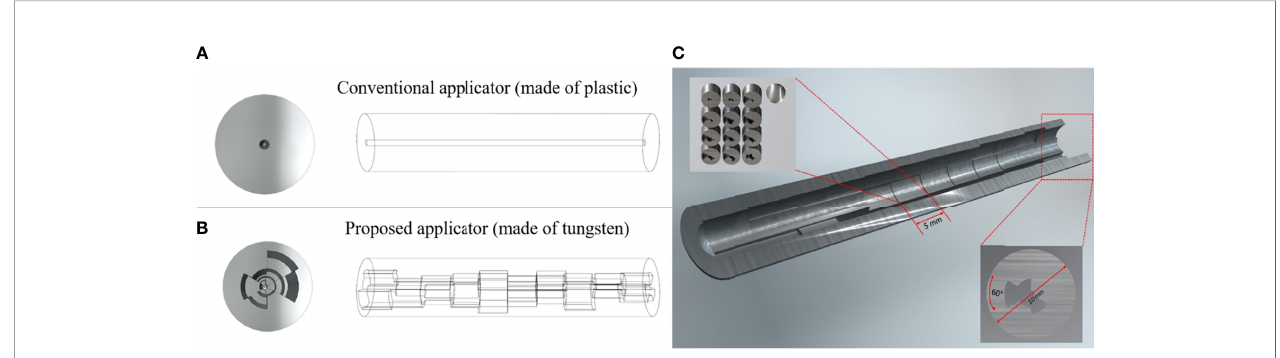
FIGURE 1 | A conceptual diagram of our prosed applicator that differs with the conventional applicator. (A) is the conventional HDR method, and (B) is the proposed HDR method, and (C) is the inside view of the whole applicator. Each dwell position has 5 mm length and the cross-section has a different shielding thickness per 60-degree